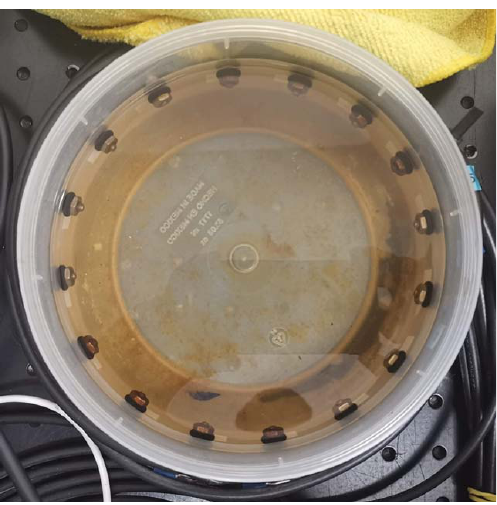
Figure 11. Test unit (vessel) with only conductive water to perform